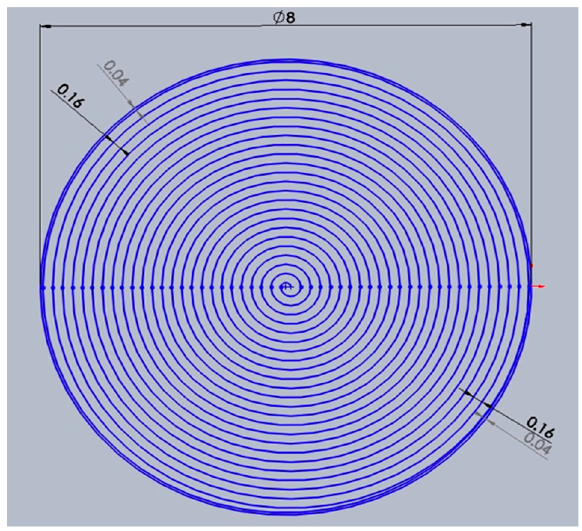
Figure 5. Spiral trepanning. Table 3. Parameters for laser spiral trepanning